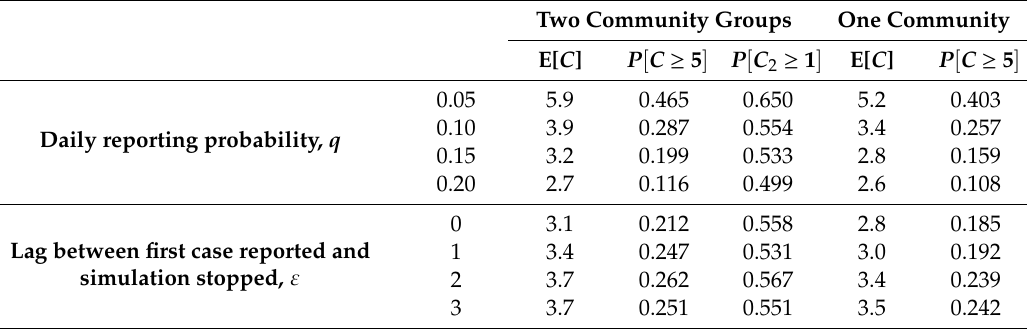
Figure 4. The average number of infected cases (E[ C ], left , blue ) and the probability of a large outbreak (P[ C ≥ 5], right , green ) as we varied the fraction vaccinated. The dashed lines are for the case of a homogenous population of 1000 while the solid lines are for the case where the population was divided into two equal-sized subgroups of 500. The red line indicates the deterministic herd immunity threshold. There were 1000 replications and the standard error was less than 0.22 for E[ C ] and 0.02 for P[ C ≥ 5]. Table 3. Additional sensitivity analysis. Here C 2 is the number of infected cases in the other subgroup (not the one with the initial infection). The number of replications was 1000. The standard error was less than 0.18 for E[ C ] and 0.02 for P [ C ≥ 5] and P [ C 2 ≥